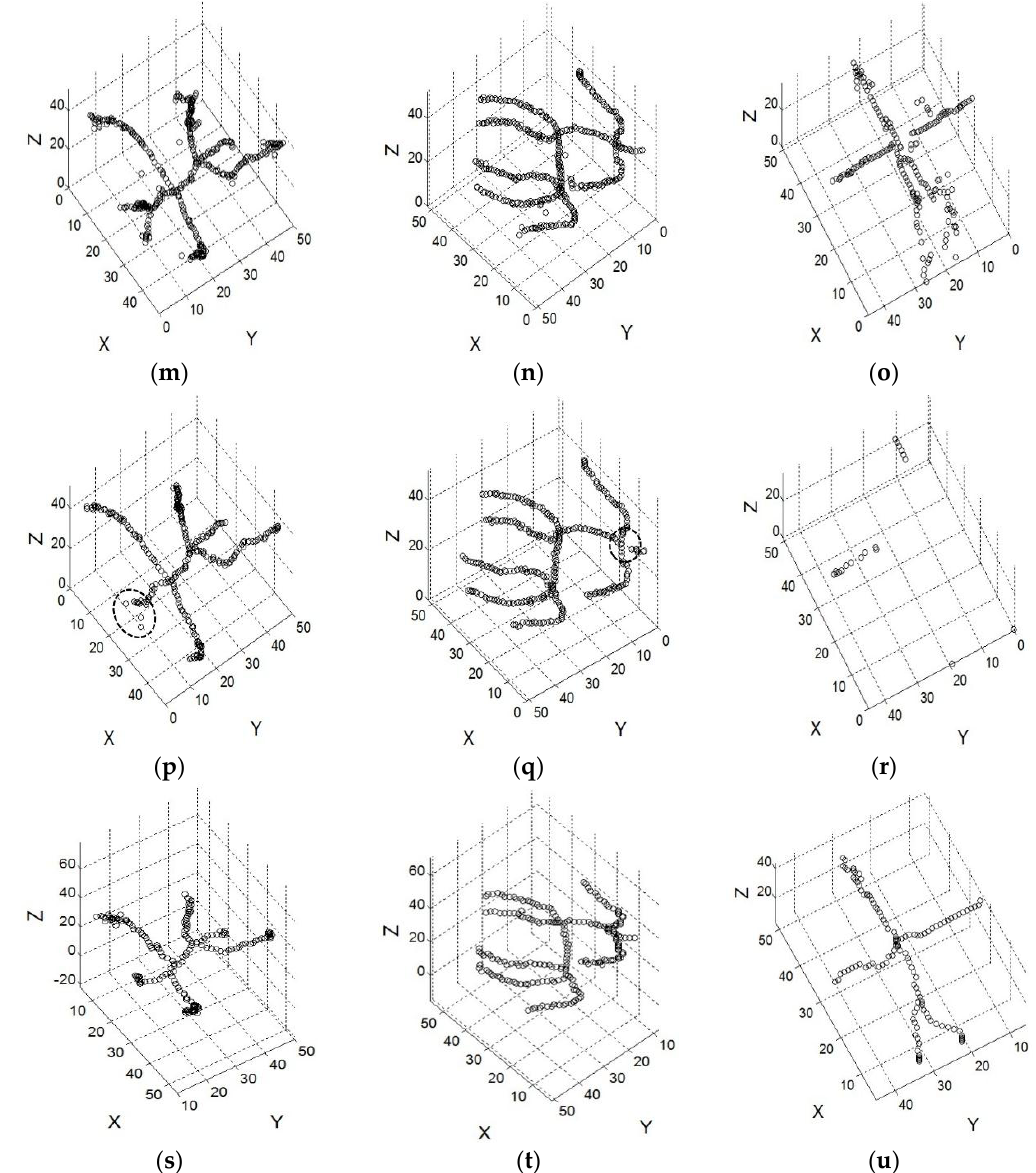
Figure 12. Skeletons extracted by five algorithms. ( a ) The skeleton of the armadillo extracted by FMM; ( b ) The skeleton of the centaur extracted by FMM; ( c ) The skeleton of the manta ray extracted by FMM; ( d ) The skeleton of the armadillo extracted by MSA; ( e ) The skeleton of the centaur extracted by MSA; ( f ) The skeleton of the manta ray extracted by MSA; ( g ) The skeleton of the armadillo extracted by MTTAC; ( h ) The skeleton of the centaur extracted by MTTAC; ( i ) The skeleton of the manta ray extracted by MTTAC; ( j ) The skeleton of the armadillo extracted by FPT; ( k ) The skeleton of the centaur extracted by FPT; ( l ) The skeleton of the manta ray extracted by FPT; ( m ) The skeleton of the armadillo extracted by CCMP with low MP score; ( n ) The skeleton of the centaur extracted by CCMP with low MP score; ( o ) The skeleton of the manta ray extracted by CCMP with low MP score; ( p ) The skeleton of the armadillo extracted by CCMP with high MP score; ( q ) The skeleton of the centaur extracted by CCMP with high MP score; ( r ) The skeleton of the manta ray extracted by CCMP with high MP score; ( s ) The skeleton of the armadillo extracted by the proposed algorithm; ( t ) The skeleton of the centaur extracted by the proposed algorithm; ( u ) The skeleton of the manta ray extracted by the proposed algorithm.